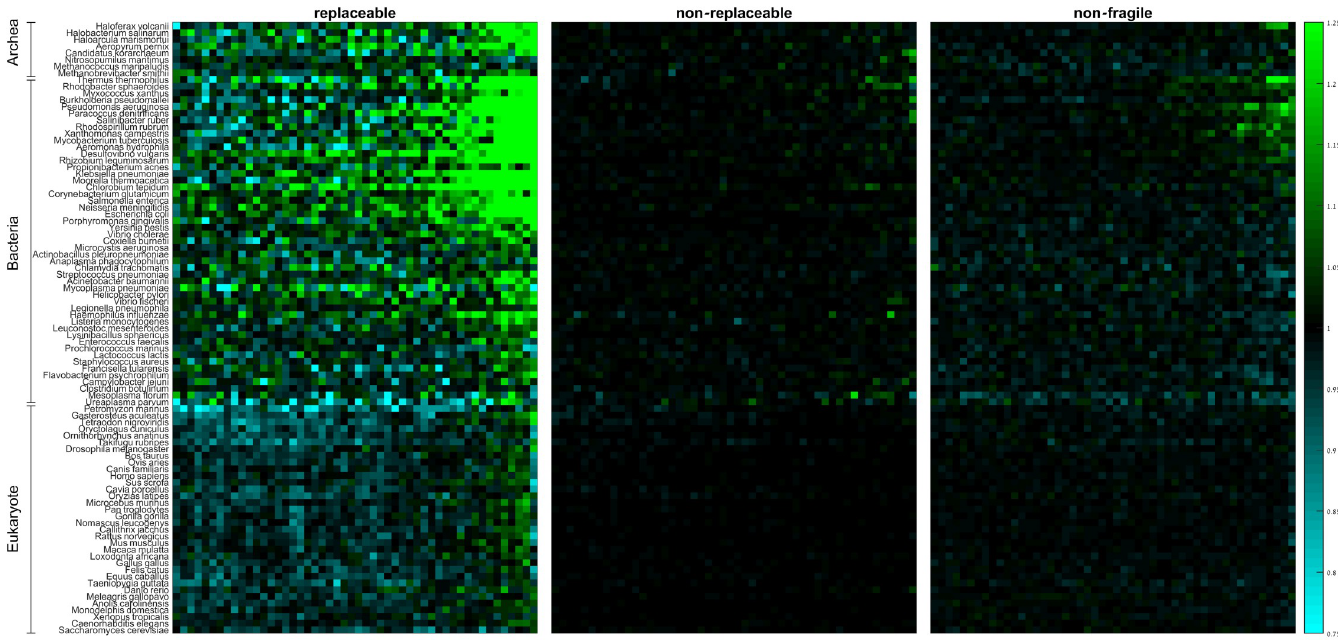
Fig 6. Group RSCA scores of replaceable, non-replaceable, and non-fragile codons along the last 50 codons of the gene. Rows denote species, columns denote positions. Species within domains are sorted from high (top) to low (bottom)